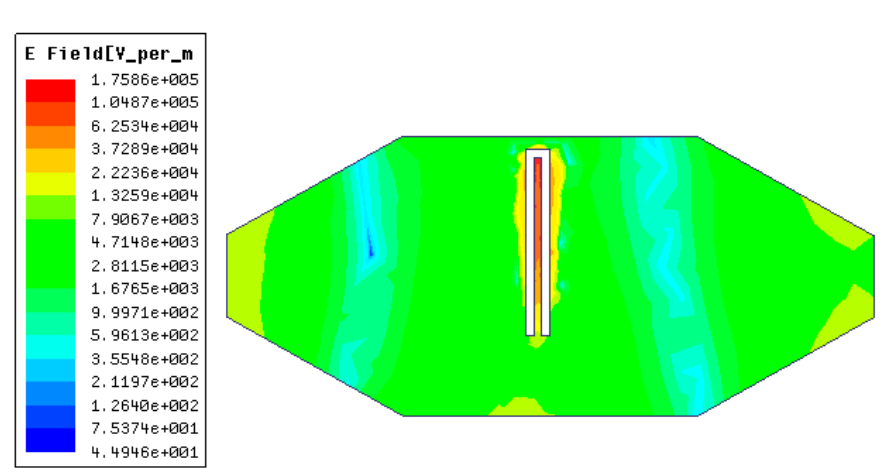
Figure 5. Electric field distribution of a single U-shaped slot resonator. The transmission characteristic curve of the single U-shaped slot resonator S21 is shown in Figure 6. When the side length of the single U-shaped slot resonator is 7 mm, the fundamental frequency of the resonator is 8.28 GHz, and the notch depth of the spectrum characteristic achieves − 22 dB. Moreover, the impedance bandwidth B is 0.04 GHz. Q-value is about 207.